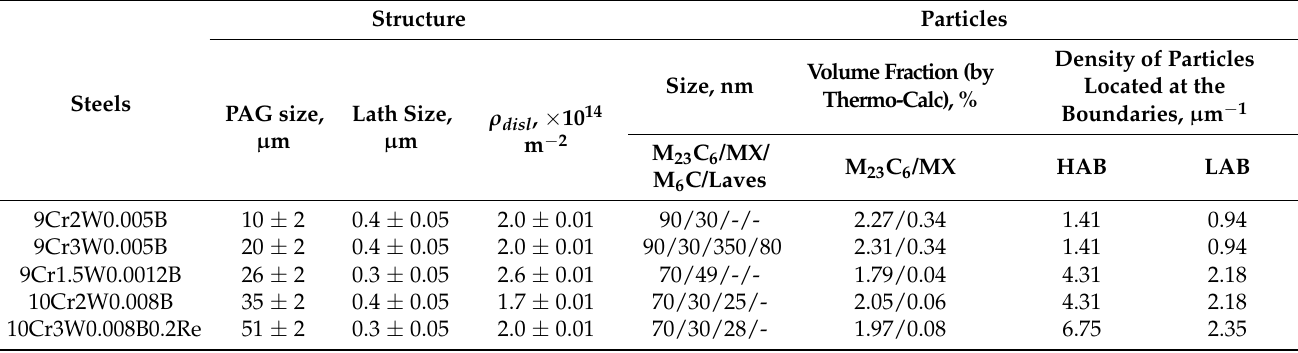
Table 2. Structural parameters of the 9–10%Cr martensitic steels after heat treatment. Structure Particles Density of Particles Volume Fraction (by Located at the Thermo-Calc), % Steels Boundaries, µ m − 1 PAG size, M 23 C 6 /MX/